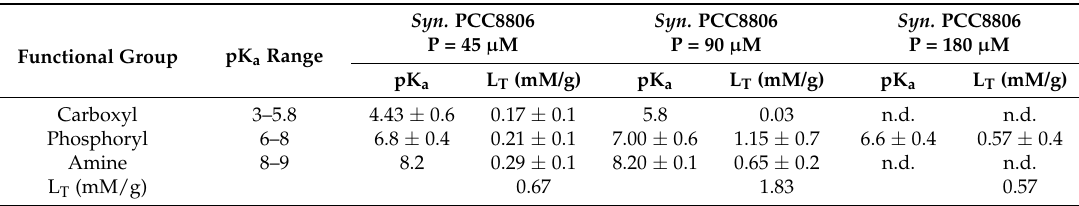
Table 1. Functional groups assignment (pK a ) and ligands concentrations determined from titration experiments by means of the linear programming method.